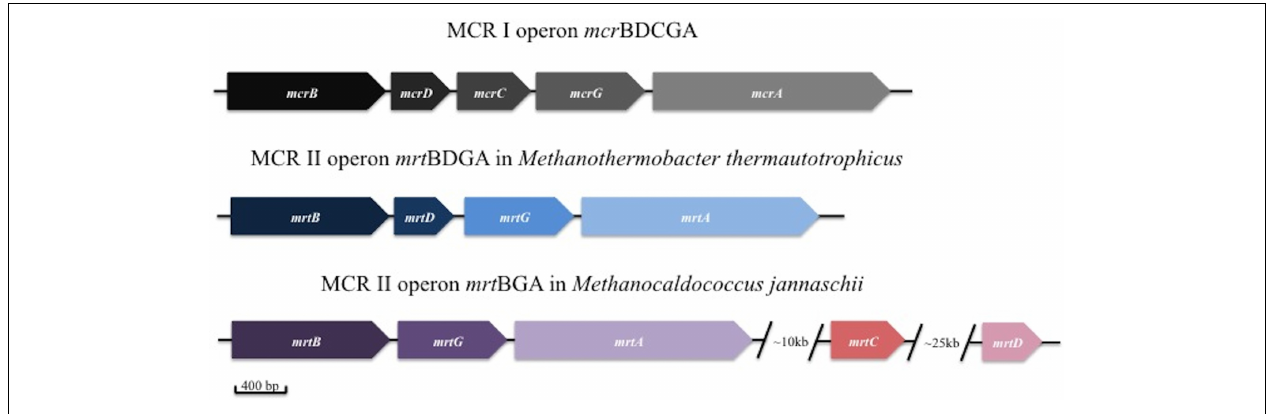
FIGURE 3 | Methyl coenzyme M reductase I (MCR I) and MCR II operon. Structure of MCR I operon rarely varies in all methanogen species while MCR II operon is different between species containing these genes (modified from Hallam etal.,